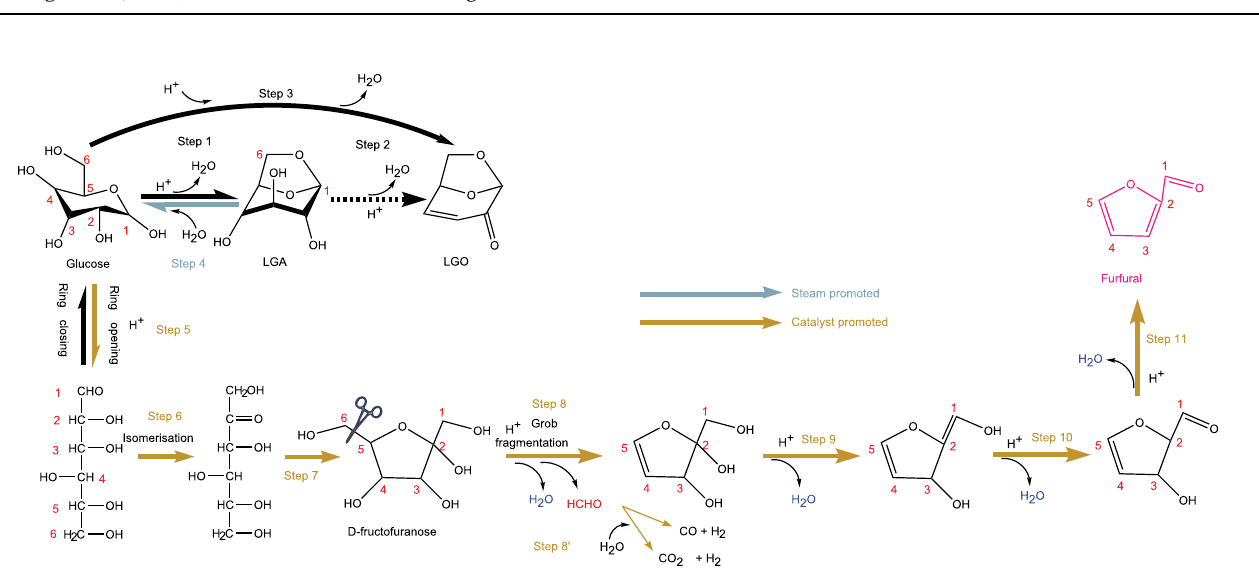
Fig. 6 | MS detection of furfural and formaldehyde from the pyrolysis of unlabeled and 13 C-labeled glucose samples. Panel a for the m/z of furfural in Py- GC-MS. Panel b for the signal intensity of m/z=31 from TGA-MS. Panel c for the TGA-MSsignalsatm/zof29,30and31fromtheblank 13 C-labeledglucoseattheC-6